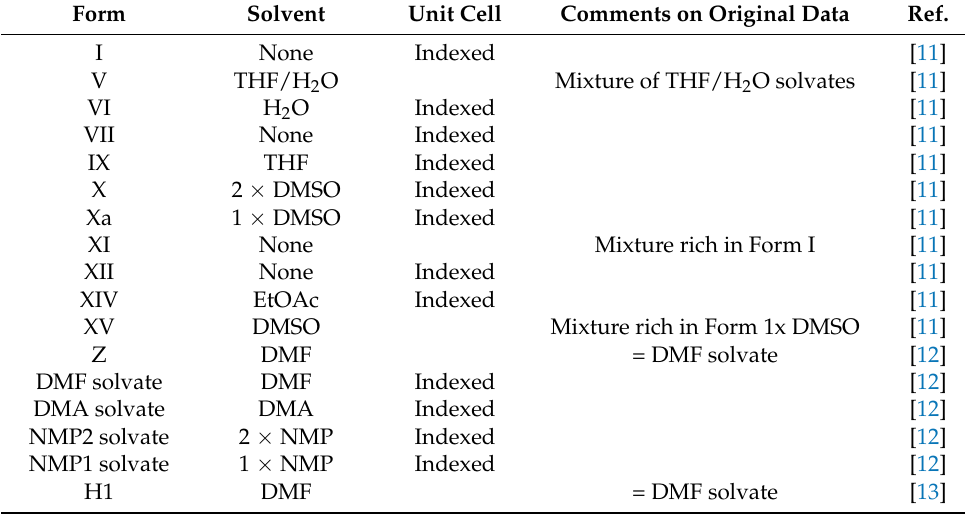
Table 15. Assignment of Eltrombopag free acid polymorphs and solvates characterized in this work, using, when possible, the original labeling, with the inclusion of the newly discovered features.